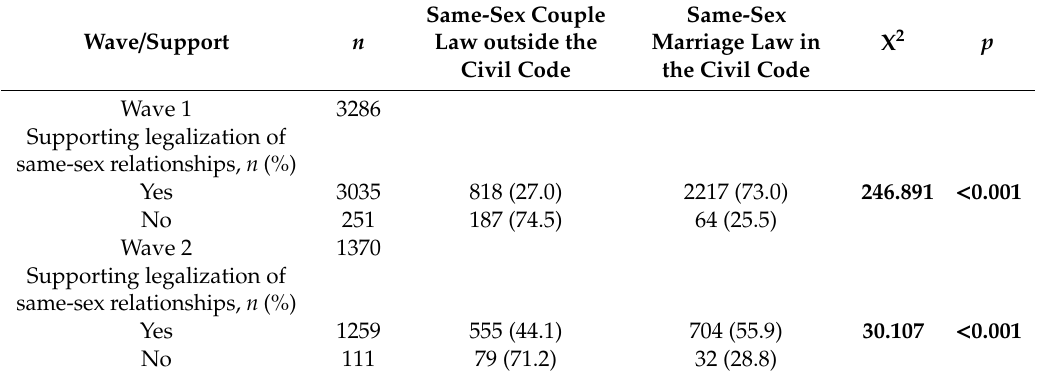
Table 1. Di ff erences in the preference of laws for the legal recognition of same-sex relationships between participants with various attitudes toward the legalization of same-sex